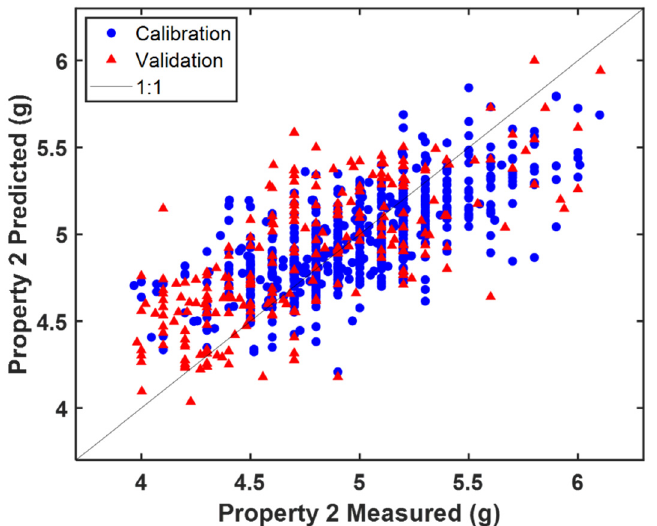
Figure 5. Predicted vs. measured value plot resulting from the ‘MB-PLS all’ model.